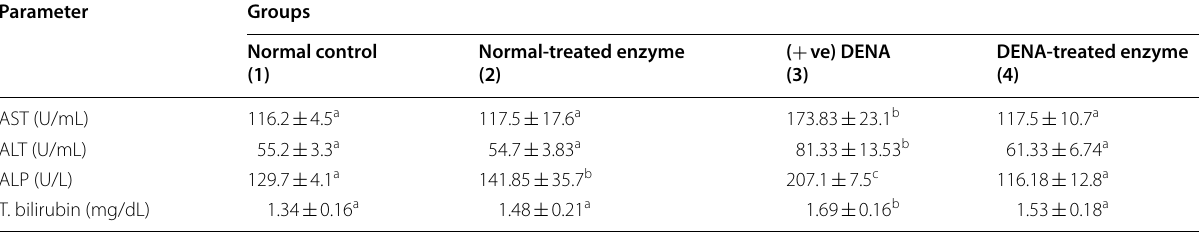
Data are expressed as means SD of six mice in each group ± Analysis of data is carried out by one‑way (ANOVA) (analysis of variance) accompanied by post hoc (LSD, least significant difference) (CoStat, computer program) Different letters indicate that these groups are significantly correlated at P > 0.05 Different letters are significantly different from each other while similar letters are not significantly different at P <